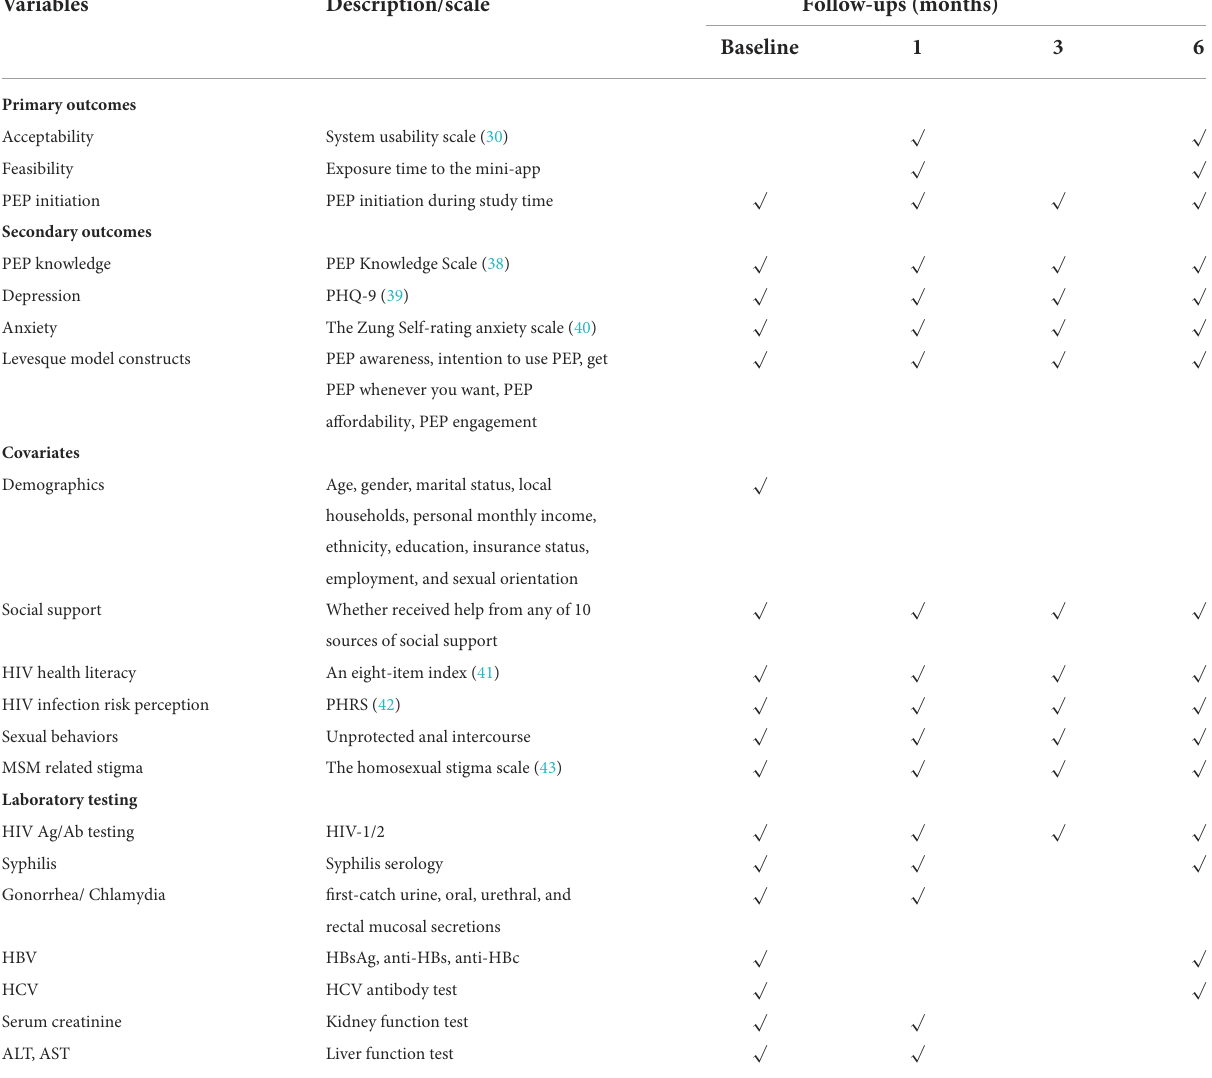
TABLE 1 Data collection and survey time